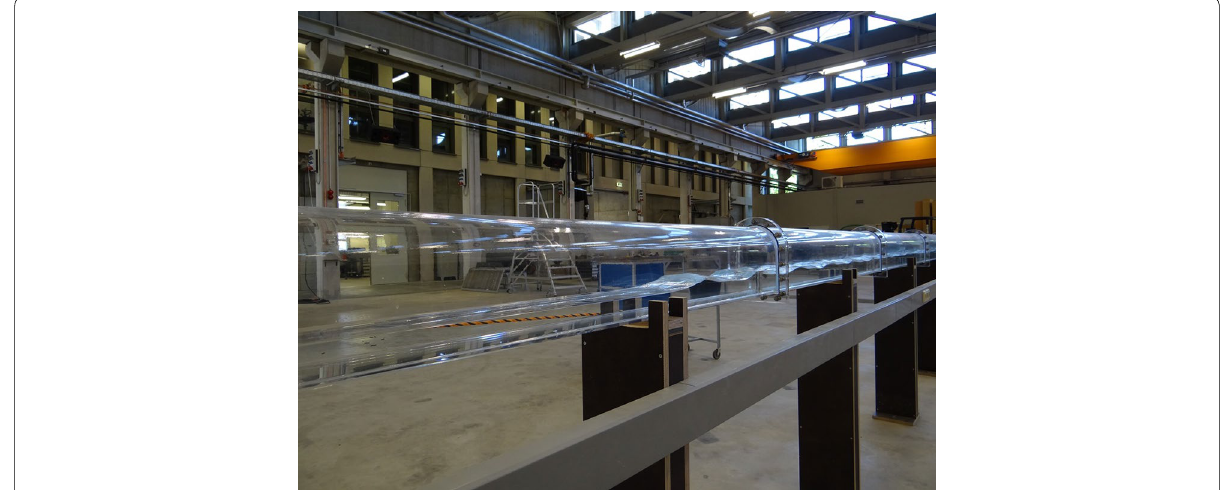
Fig. 5 Model of underground pumped‑storage plant. With a length of about 36 m, the model is used to assess flow conditions in